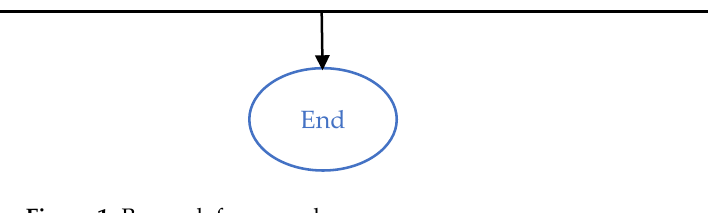
Figure 1. Research